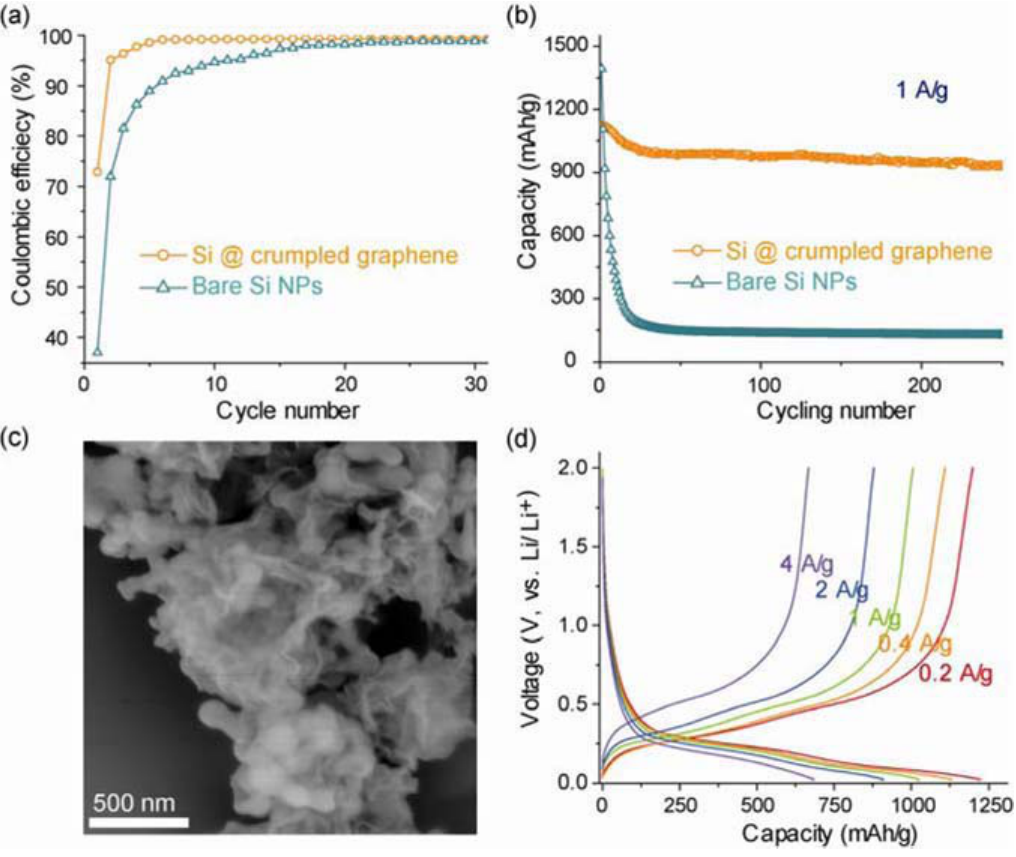
Figure 10. Electrochemical performance of the Si–crumpled graphene. ( a ) Coulombic efficiency and ( b ) charge/discharge cycling test of the composite capsules in comparison to the unwrapped Si nanoparticles at a constant current density of 1 A/g. ( c ) SEM image of the capsules after 250 cycles. ( d ) Charge/discharge profiles of the composite s electrode at various current densities ranging from 0.2 to 4 A/g. Adapted with permission from [86]. Copyright 2012 American Chemical